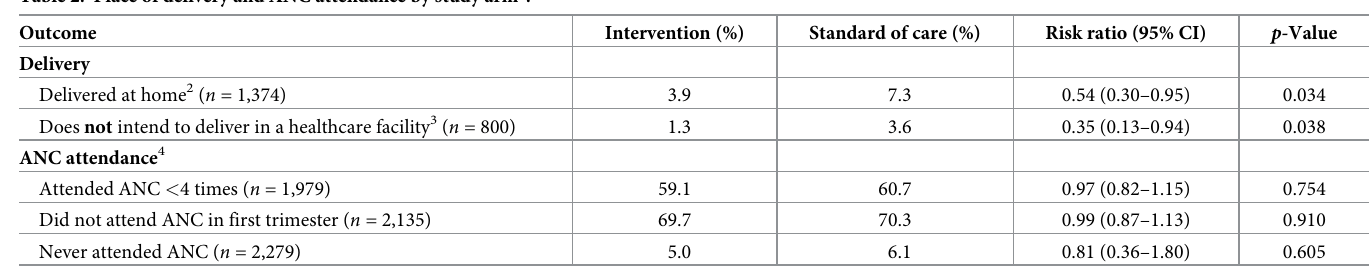
Table 2. Place of delivery and ANC attendance by study arm 1